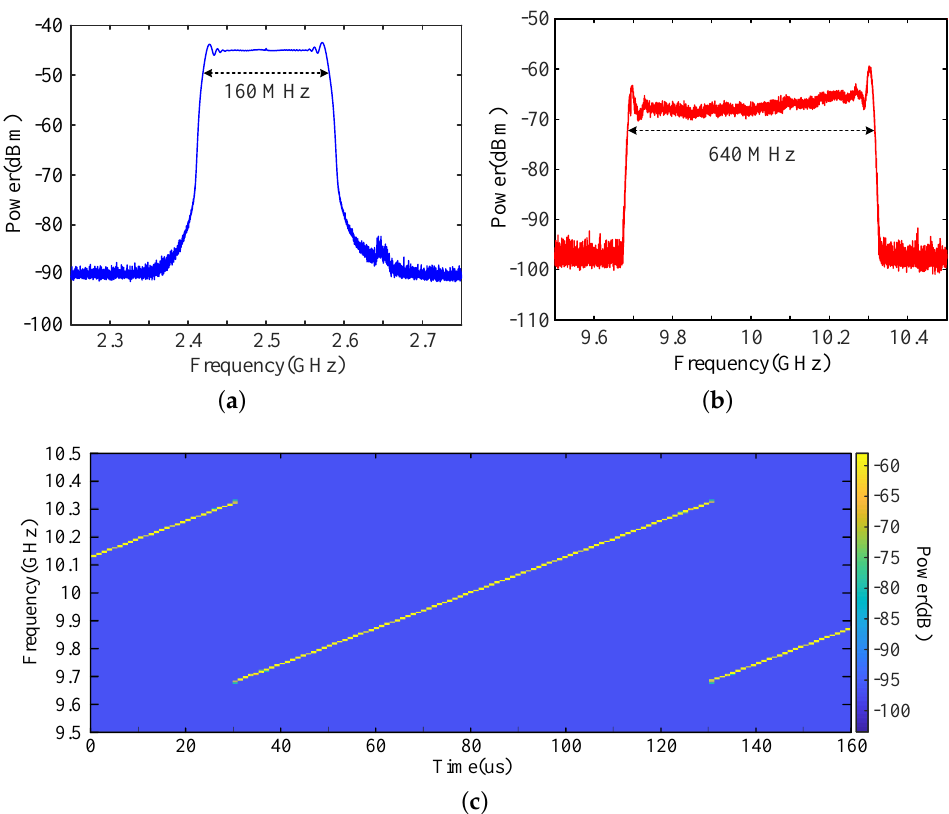
Figure 5. Cahracteristics of the transmitted signals. ( a ) Max-hold spectrum of the IF-band signal. ( b ) Max-hold spectrum of the quadrupled signal. ( c ) Spectrogram of the quadrupled signal with a 640-MHz bandwidth and 100- µ s period.